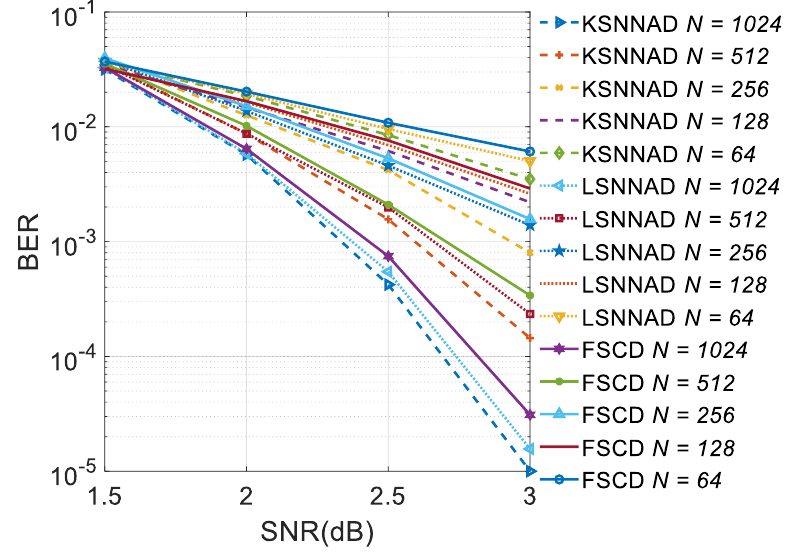
Figure 15. Decoding results of different code lengths.